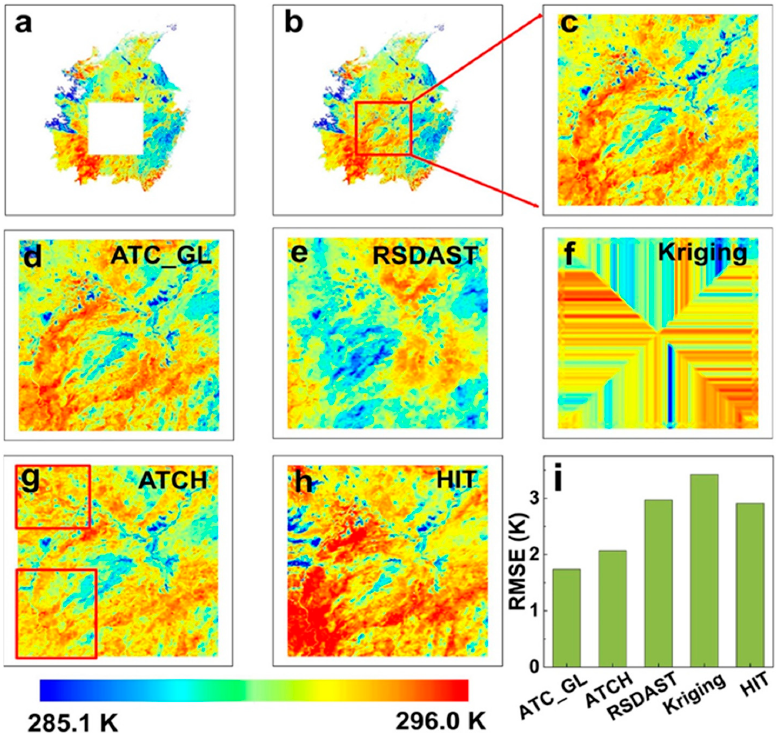
Figure 10. The spatial details of the LSTs reconstructed using various methods with an LST gap size of 500 × 500 pixels. Subfigure ( a ) denotes the LST gap on an image from 10 March 2018; subfigures ( b , c ) are the original true LSTs; subfigures ( d – h ) represent the LSTs reconstructed by the ATC_GL, RSDAST, Kriging interpolation, ATCH, and HIT, respectively; subfigure ( i ) presents the mean RMSEs of the different methods.